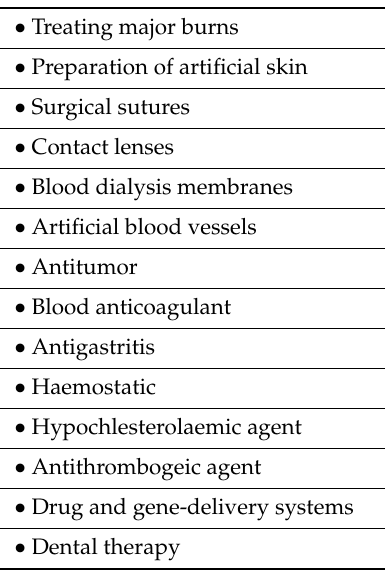
Table 4. Some applications of chitosan in biomedical and pharmaceutical